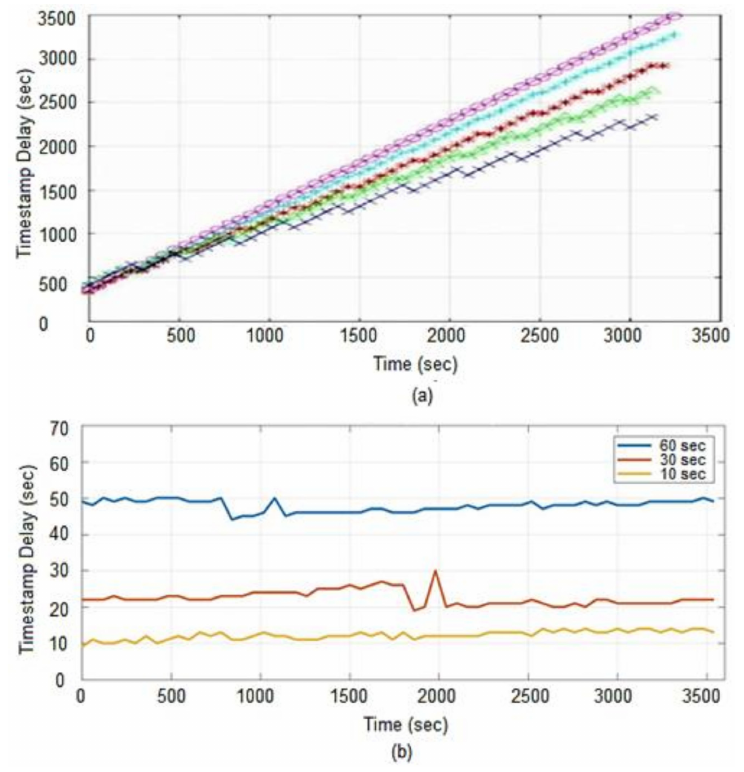
Figure 12. Timestamp delay ( a ) Ceilometer ( b )